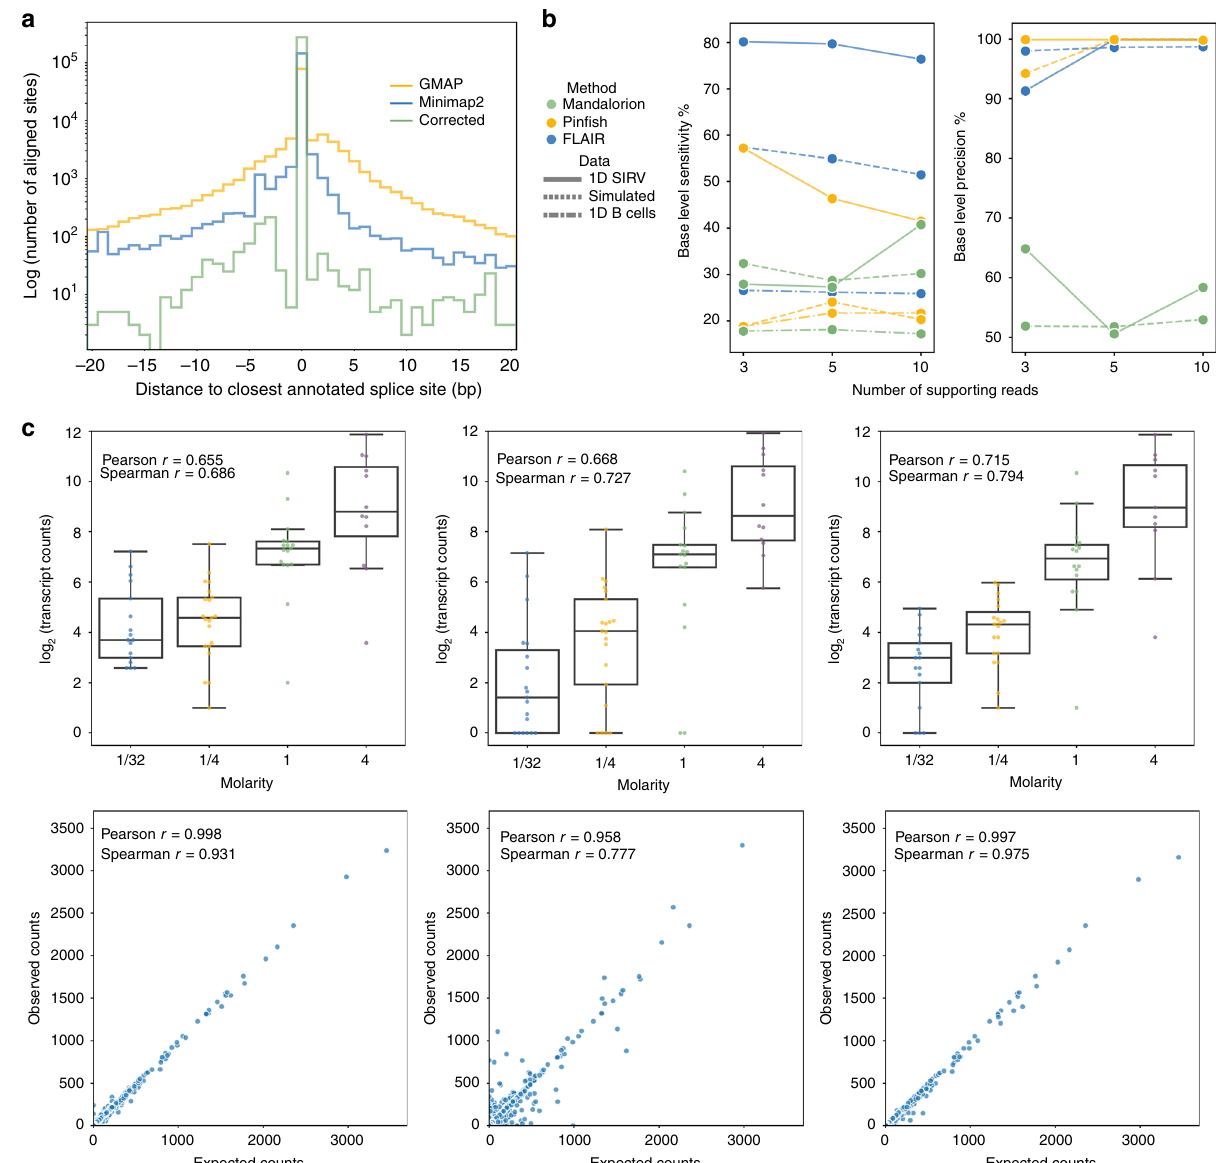
Fig. 2 Evaluation of nanopore read alignment, correction, transcript assembly, and transcript quanti fi cation. a Histogram showing the distance between splice sites determined using the GMAP (yellow) or minimap2 (blue and green) spliced aligners to the closest annotated splice sites for a subset of the CLL SF3B1 K700E reads; the minimap2 aligned vs annotated splice-site histogram was further distinguished between alignments that had (green) or had not (blue) been subject to FLAIR splice correction. b Base-level sensitivity (left) and precision (right) of isoform sets built using Mandalorion (green), Pin fi sh (yellow), or FLAIR (blue). Each software tool was run with varying supporting read thresholds ( x -axis) on either nanopore-sequenced 1D SIRVs (solid line), a set of simulated nanopore transcript reads (dashed), or 1D B cell reads subsampled down to 500,000 reads (dot dash). c Comparison of transcript quanti fi cation methods for nanopore reads plotting the expected and observed transcript abundances of the SIRV data (top row) and simulated data (bottom row). First column: counting primary alignments, second column: salmon given all alignments, third column: counting MAPQ ≥ 1 alignments. Box- plots show median line, box limits are upper and lower quartile, and whiskers are 1.5×